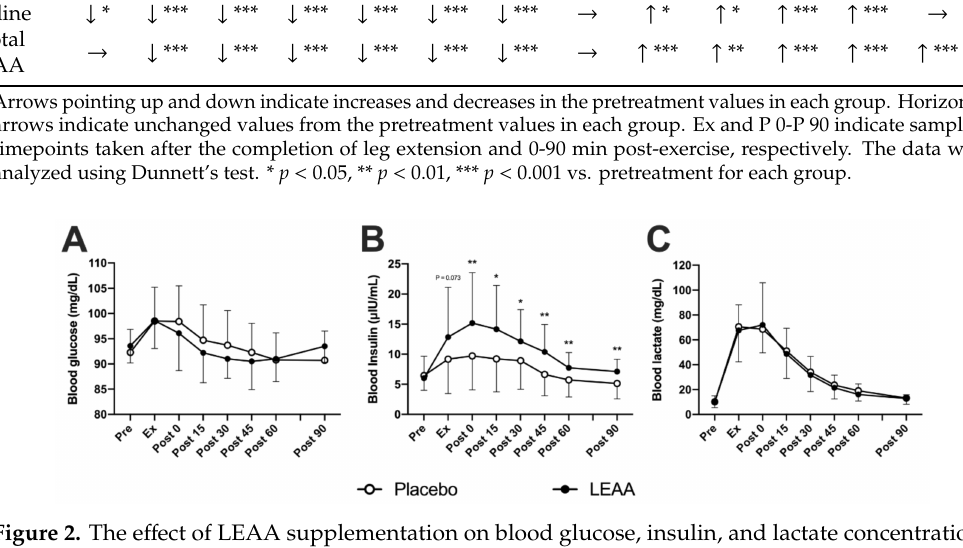
Figure 2. The e ff ect of LEAA supplementation on blood glucose, insulin, and lactate concentrations after a single bout of resistance exercise. ( A ) Blood glucose, ( B ) blood insulin and ( C ) blood lactate. Data are expressed as the mean ± SD. The data were analyzed using ANCOVA adjusted for baseline values. * p < 0.05, ** p < 0.01 vs. the placebo group at the same time